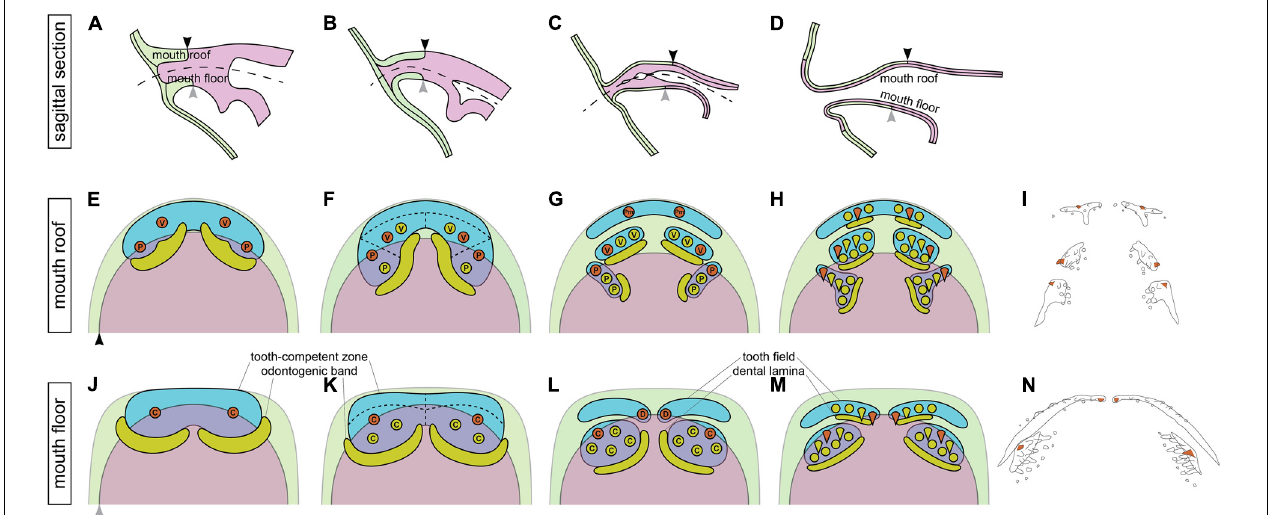
FIGURE 7 | Relations between the germ-layer distribution and patterning of the axolotl dentition. During the course of the axolotl mouth development, oral ectoderm and endoderm do not form a sharp boundary, but instead the basal layer of oral ectoderm involutes to constitute the basal layer of the nascent oral epithelium while the solid endoderm forms the apical layer (A–D) . As a result, the ecto-endodermal boundary within the basal layer of the mouth roof (black arrowhead) and floor (gray arrowhead) is different from that within the apical layer. The broken line in (A–C) shows the place of the future mouth cavity. Tooth-competent zones become established in the basal epithelial layer of the mouth roof and floor (blue regions in E,F,J,K ) and later become separated into the prospective tooth fields (blue regions in G,H,L,M ). Tooth germs arise progressively during the process of this separation. Orange circles mark the positions of the initiator-teeth of each prospective tooth field and yellow circles denote positions of successively added tooth germs. Yellow regions mark positions of odontogenic bands at earlier stages (E,F,J,K) and successional dental laminae at later stages (G,H,L,M) . Green and magenta regions show the extent of oral ectoderm and endoderm, respectively. Only the basal epithelial layer, i.e., the tooth-forming layer of the double-layered epithelium, is depicted (the black and gray arrowheads in E,J correspond to those in A–D ). First, tooth germs of vomerine (V), palatine (P), and coronoid (C) tooth fields appear prior to those of the premaxillary (Pm) and dentary (D) tooth fields. The initiator-teeth of palatine, coronoid, and dentary tooth fields stereotypically arise at the boundary of ectoderm (green) and endoderm (magenta) (orange circles in F,K,L ), while the initiator-teeth of the premaxillary and vomerine tooth fields arise from ectoderm (orange circles in E,G ). The successive tooth germs arise from ectoderm in the case of premaxillary and dentary tooth fields, from endoderm in the case of palatine and coronoid tooth fields, and from ectoderm or ecto-endoderm in the case of vomerine tooth fields (F–H,K–M) . These early events in oro- and odontogenesis lead to the salamander-specific distribution of teeth on the bones of the upper and lower jaws and on the palate (I,N) . Orange teeth in (I,N) represent the initiator-teeth of each tooth field. (I,N) are schematized Figures 1B,C , respectively. den, dentary; pal, palatine; pmx, premaxillary; cor, coronoid; vom,